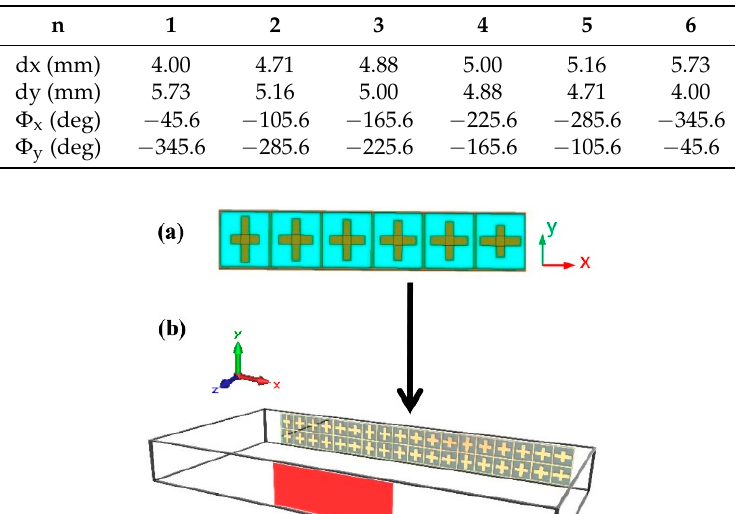
Table 1. Sizes and phase distributions of the six unit cells.